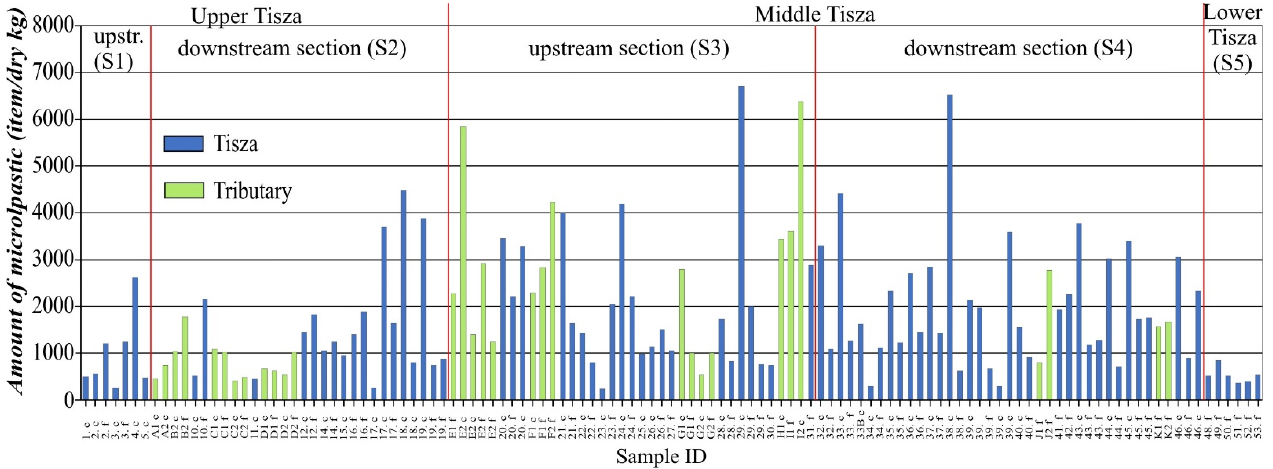
Figure 4. Microplastic content (item/dry kg) of the sediments collected in 2020 along the various sections of the Tisza River (S1 ‒ S5) and its tributaries joining the given section. At each sampling site, fine-grained (f) and also coarse-grained (c) samples were collected.